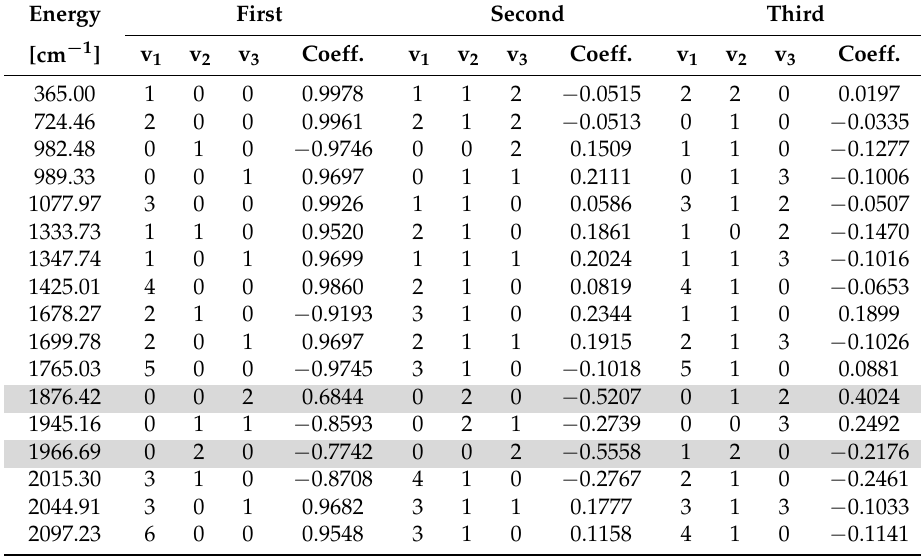
Table 5. Coupling of the vibrational states of the ground electronic state of the Li 2 H complex. The more strongly coupled states are highlighted in